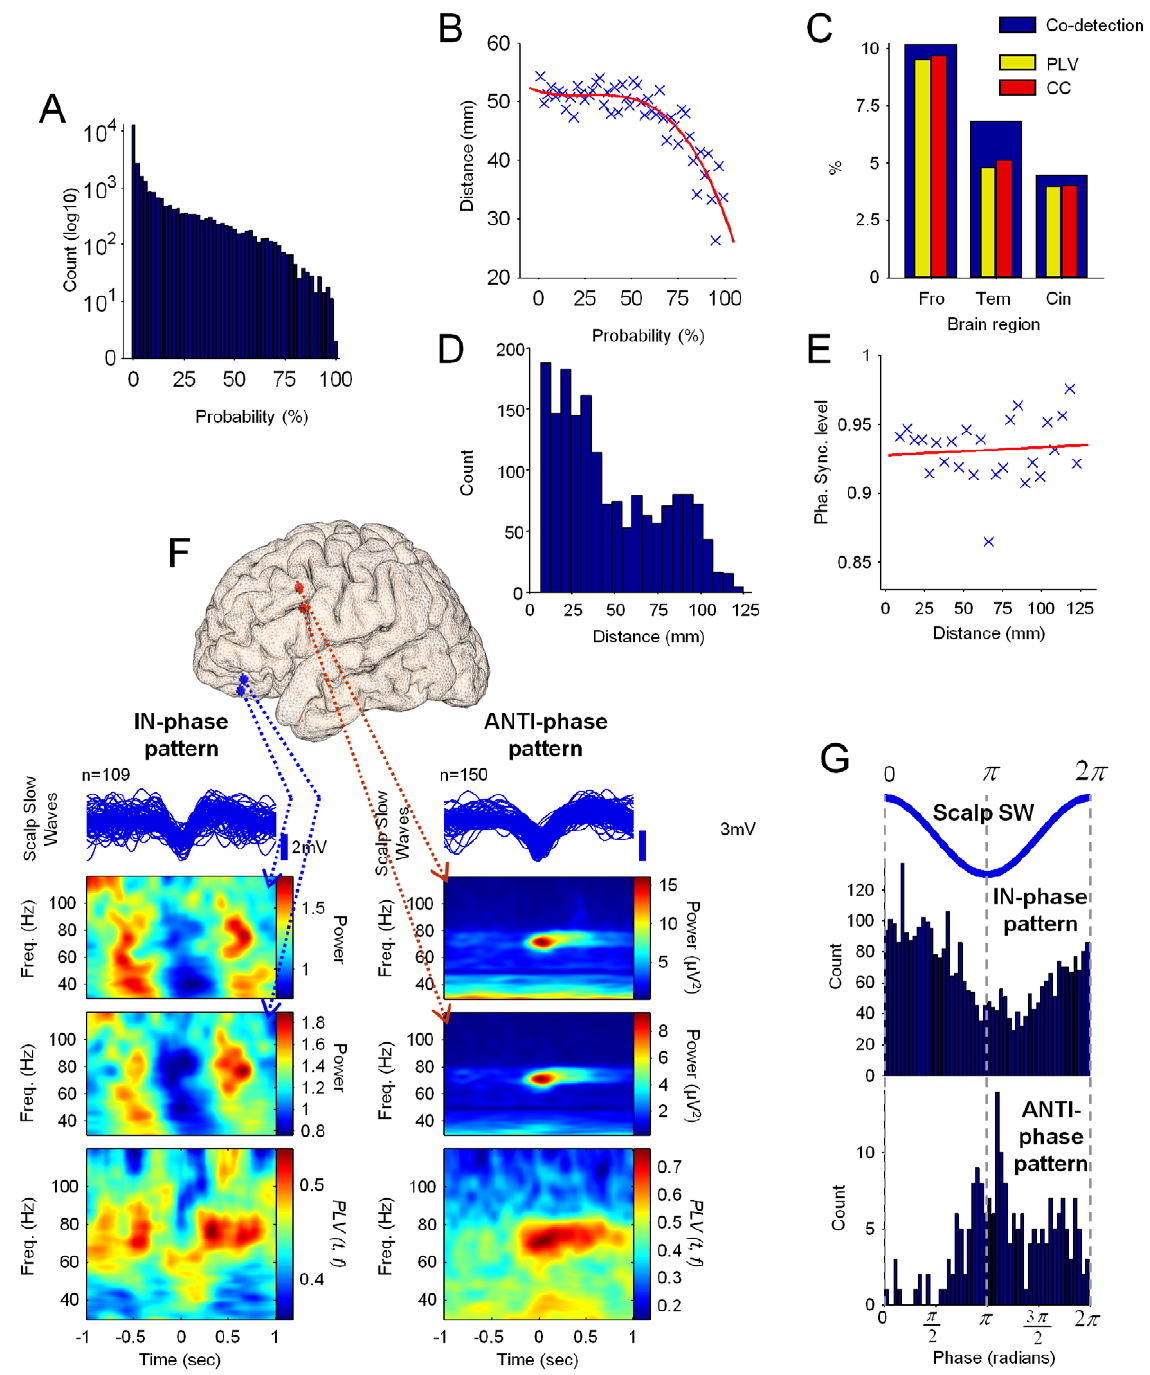
Figure 7. Synchronization of gamma events occurring at different intracranial contacts during slow waves. ( A ) Distribution of co- detection probability for all analyzed contacts (n=20 subjects). ( B ) Distribution of the co-detection probability vs. the distance between pairs of contacts and the corresponding regression curve (red line, n=11 subjects). ( C ) Percentages of contact pairs presenting a co-detection probability $ 50% and located in frontal, temporal and cingulate cortex (wide blue bars in background), and corresponding percentages having significant PLV and CC values (yellow and red bars in foreground respectively, n=20 subjects). ( D ) Histogram of the distance between pairs of contacts for all cases presenting co-detection probability $ 50% and statistically significant PLV (n=11 subjects). ( E ) Plot of the distance between contact pairs vs. the PLV level with the corresponding regression curve ( red line ) (n=11 subjects). ( F ) Examples of contact pairs presenting statistically significant phase synchronization modulated by IN-phase and ANTI-phase patterns. From top to bottom: superimposed scalp slow-waves associated with the first contact in the pair (see below), aligned around the central peak; Average time-frequency representations of the power for the first and second contacts; Phase-locking value for the phase difference between both contacts along all slow waves. Pairs of contacts ( first and second ) were implanted for subjects P7 and P13 respectively in the following locations: orbital sulcus and olfactory sulcus ( left ), frontal superior sulcus and frontal inferior sulcus ( right ). The distance between pairs of contacts shown in both examples was 10 mm. ( G ) Histograms presenting the distribution of the